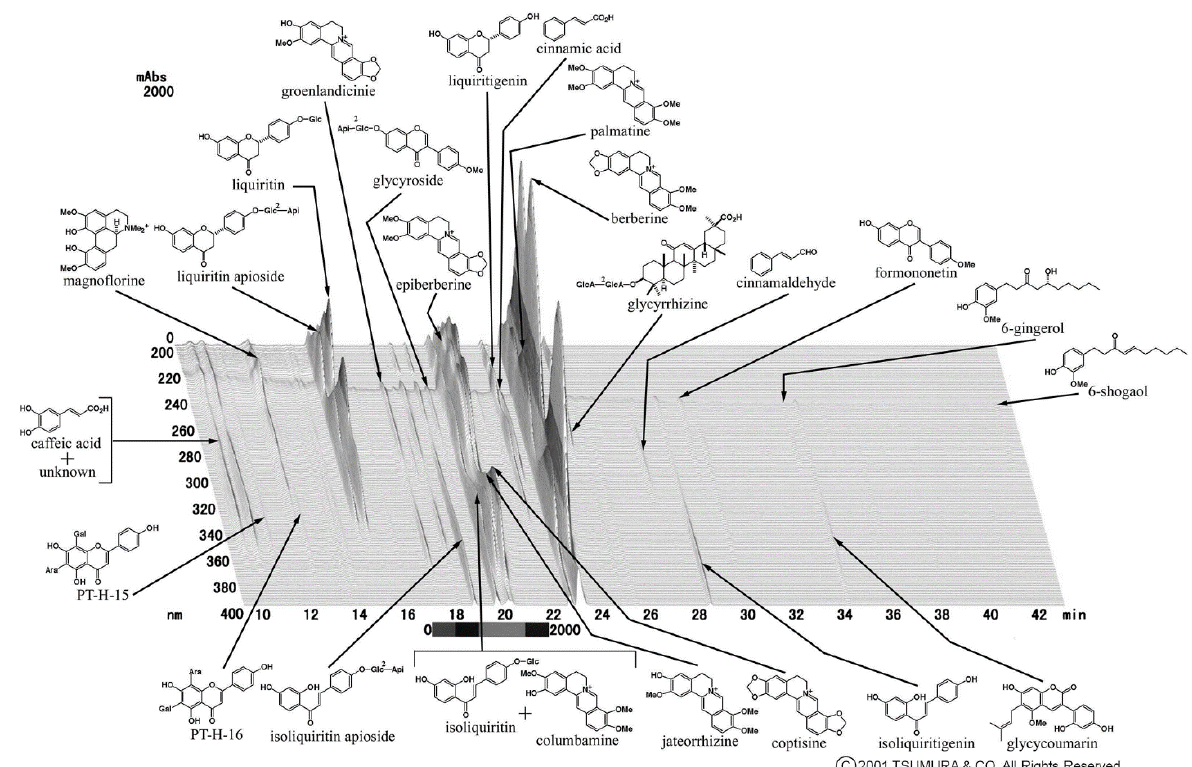
Figure 5. Three-dimensional high-performance liquid chromatography profile of orento (provided by Tsumura, Tokyo,